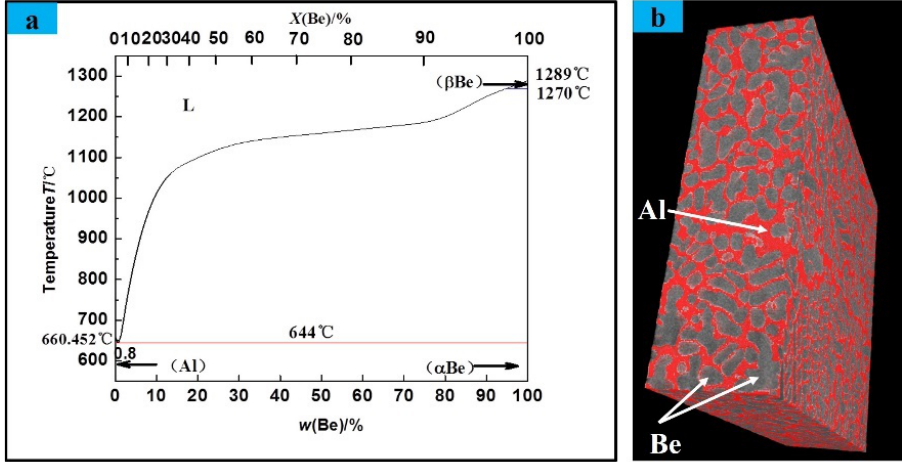
Figure 1. The phase diagram of Be-Al alloy ( a ), three-dimensional microstructure ( b ) [19]. Reprinted/adapted with permission from Ref. [19]. Copyright 1994, Elsevier Ltd.